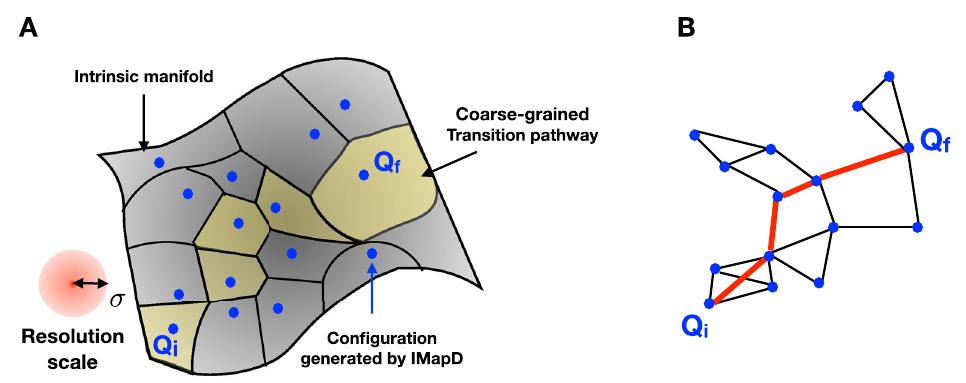
Figure 2. ( a ) Illustration of the coarse-grained representation of the Langevin dynamics. Dots represents configurations generated using iMapD, which lie on the intrinsic manifold. Each such configuration is regarded as a representative element of its Voronoi cell. Coarse-grained trajectories are identified by sequences of Voronoi cells, I . A typical transition path is highlighted in yellow. The intrinsic resolution scale σ of the effective theory is set by the average distance between the configurations generated by iMapD. ( b ) Graph representation of the coarse-grained Langevin dynamics. The red line denotes the transition path highlighted in yellow in panel ( a